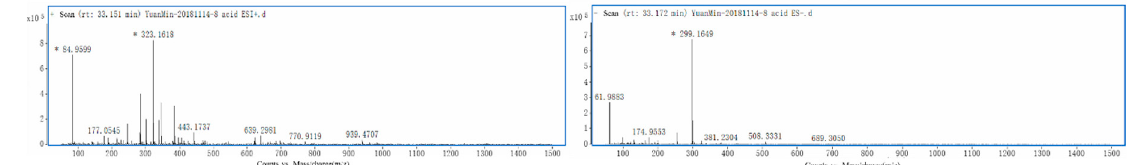
Figure 2. The primary mass spectrum for each of the seven phenolic acids in both positive and negative ESI modes: Chlorogenic acid (1) with (M + Na) + at m / z 377 and (M − H) − at m / z 353, whereas ca ff eic acid (2) with (M + Na) + at m / z 203 and (M − H) − at m / z 179, isochlorogenic acid B (3) with (M + Na) + at m / z 539 and (M − H) − at m / z 515, isochlorogenic acid A (4) with (M + Na) + at m / z 539 and (M − H) − at m / z 515, isochlorogenic acid C (5) with (M + Na) + at m / z 539 and (M − H) − at m / z 549, ca ff eic acid phenethyl ester (6) with (M + Na) + at m / z 307 and (M − H) − at m / z 283, and artepillin C (7) with (M + Na) + at m / z 323 and (M − H) − at m / z 299. Table 1. The identification of seven phenolic acids from Brazilian propolis samples in both positive and negative ESI modes. No. t R /